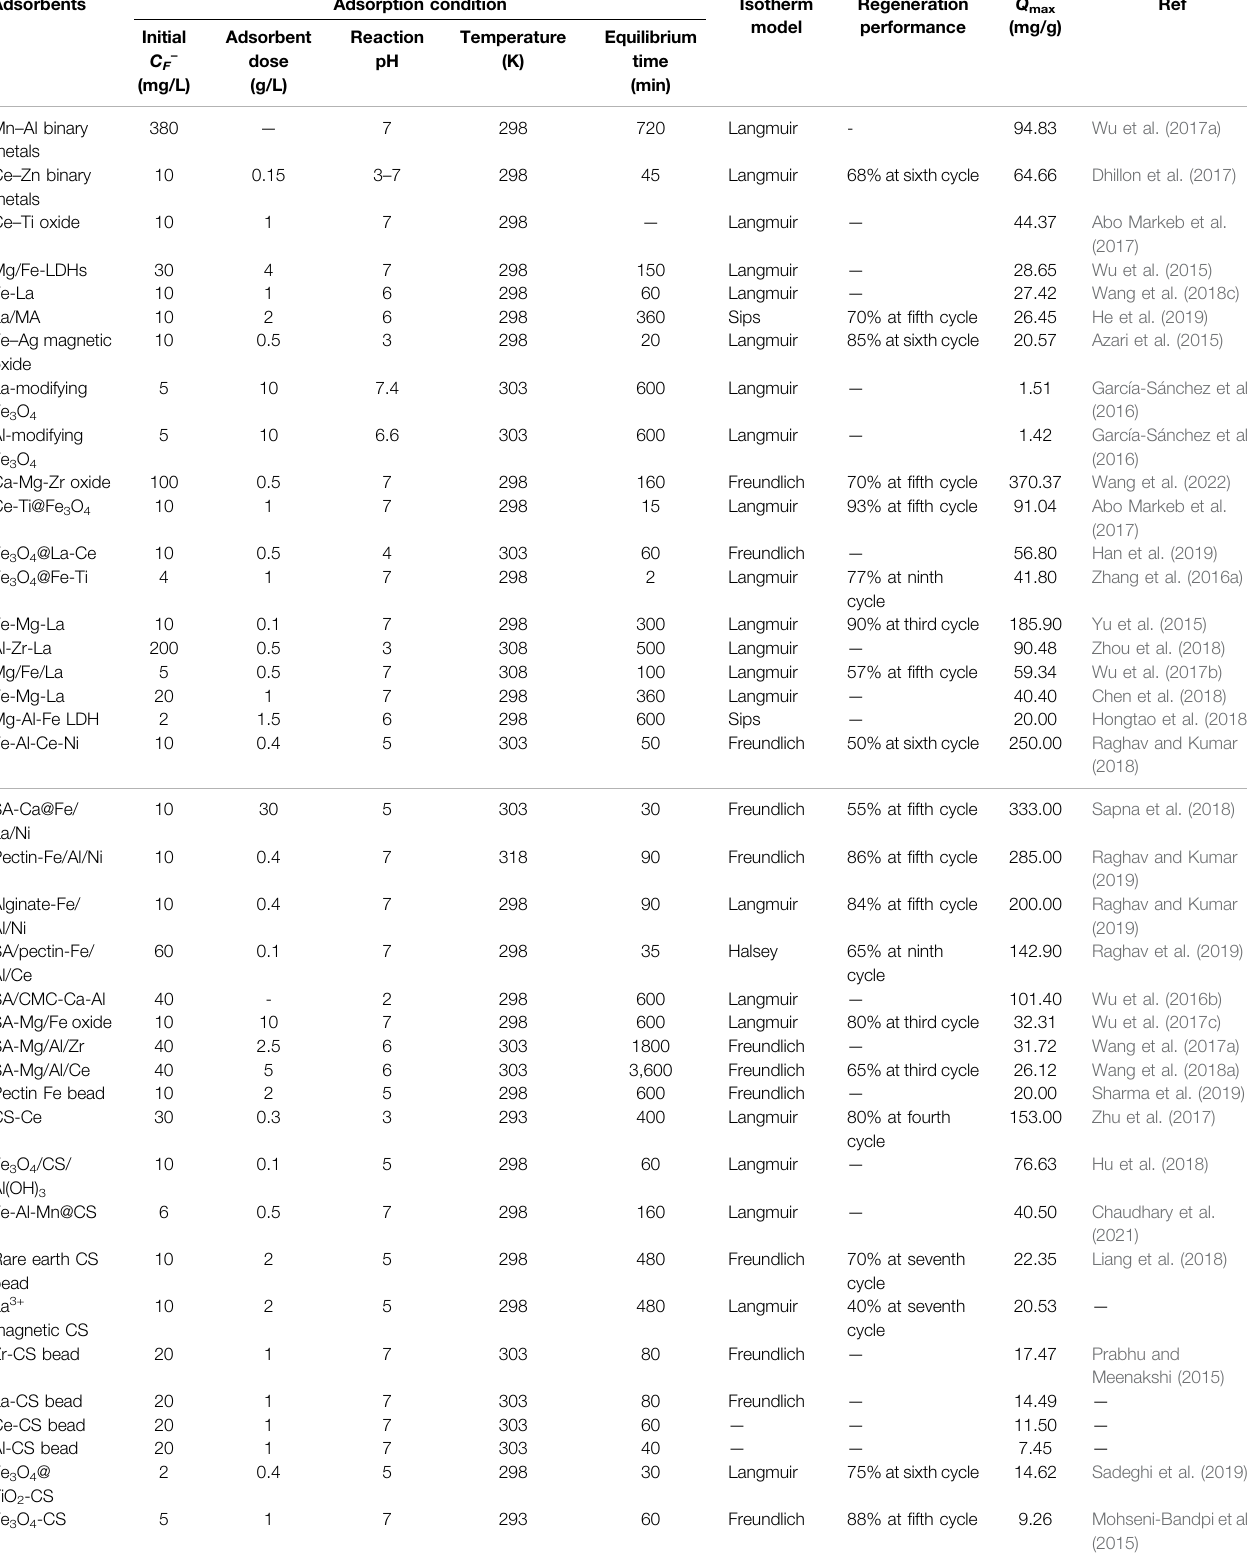
TABLE 3 | Adsorption conditions and performance of fl uoride by muti-metal and metal-biopolymer composite adsorbents.